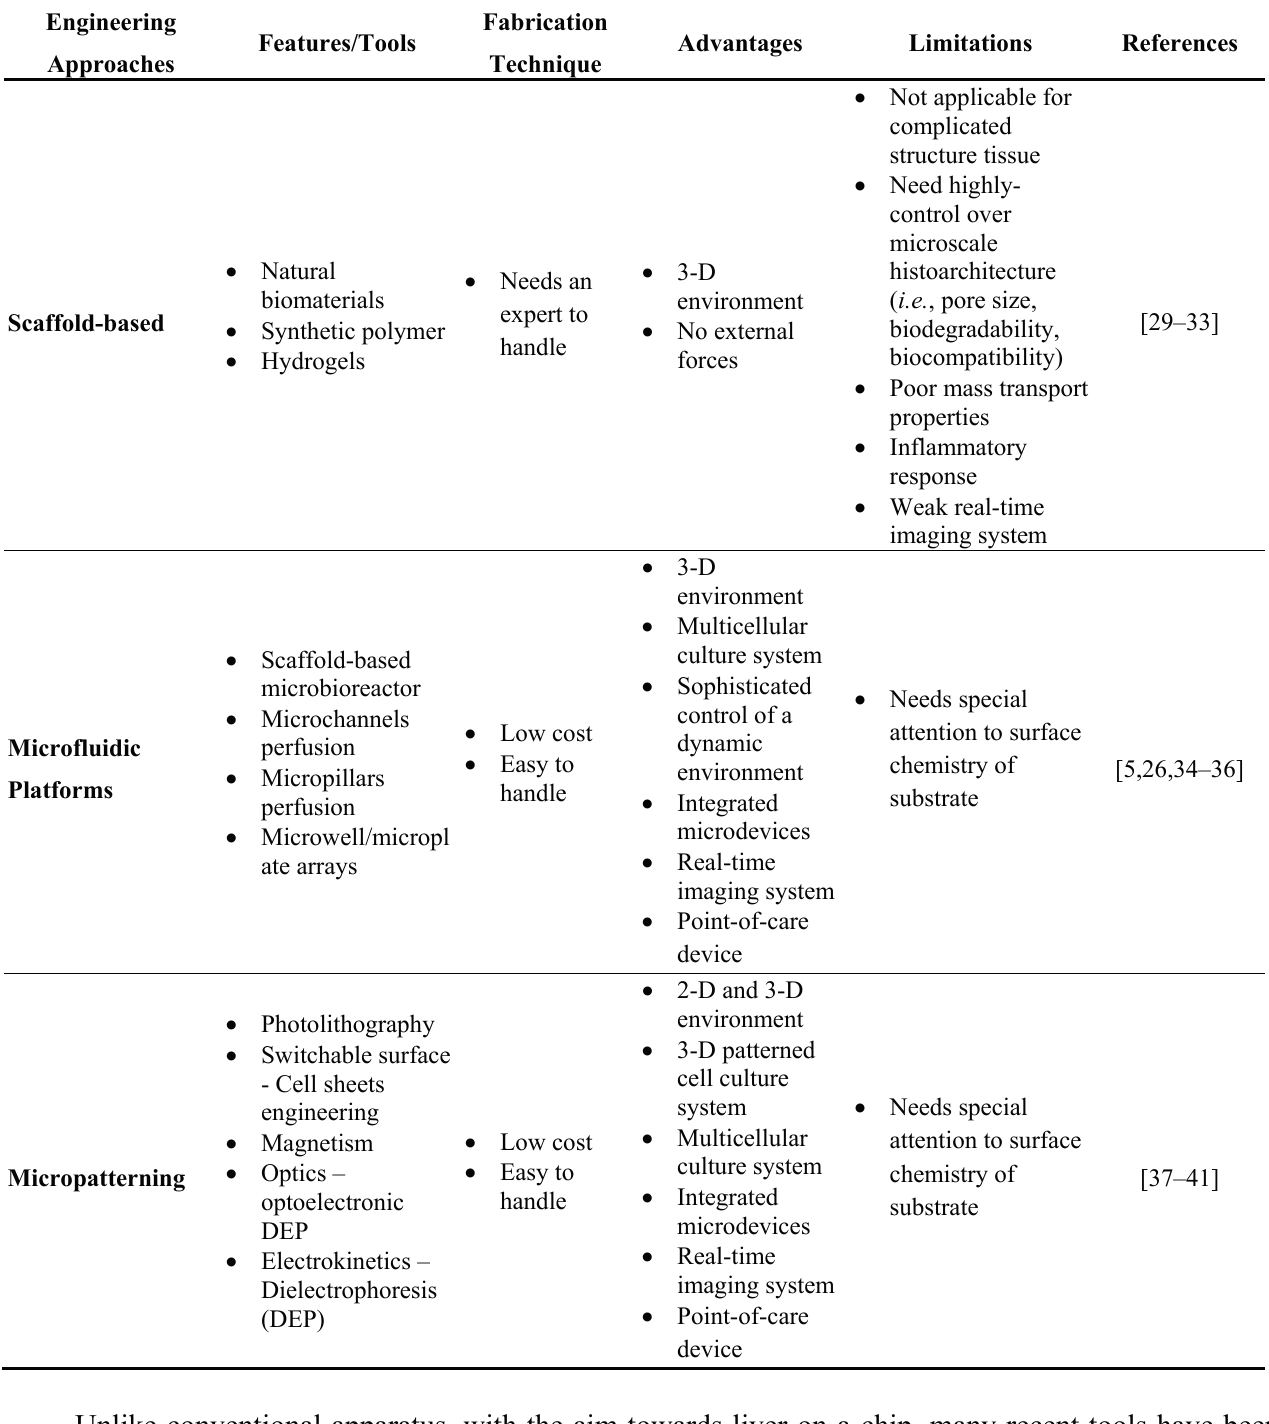
Table 1. Comparison between available engineering